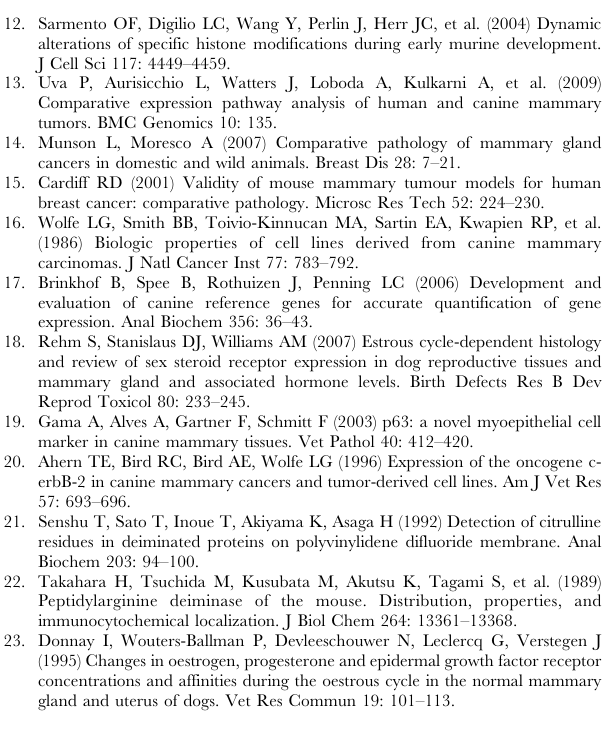
Figure S1 Immunohistochemitry in canine mammary with PAD-4. (A) As an IHC control, anestrus, estrus/early diestrus, and late diestrus mammary tissue sections were probed with equal concentration of rabbit IgG (compared to anti-PAD2) and counterstained with hematoxylin. (B) Anestrus, estrus/early diestrus, and late diestrus mammary tissue sections were are also probed with an anti-PAD4 antibody, and opposite of PAD2 staining, showed highest PAD4 levels in anestrus with lowest staining during late diestrus. Figure S2 The PAD2 antibody is not cross reactive with other PAD family members. Mammalian expression plasmids contain- ing the cDNA for human PADs 1, 2, 3, and 4 were transiently transfected into human embryonic kidney 293 cells. After 24 hours, cells were harvested and overexpression lysates run on a western blot probed with